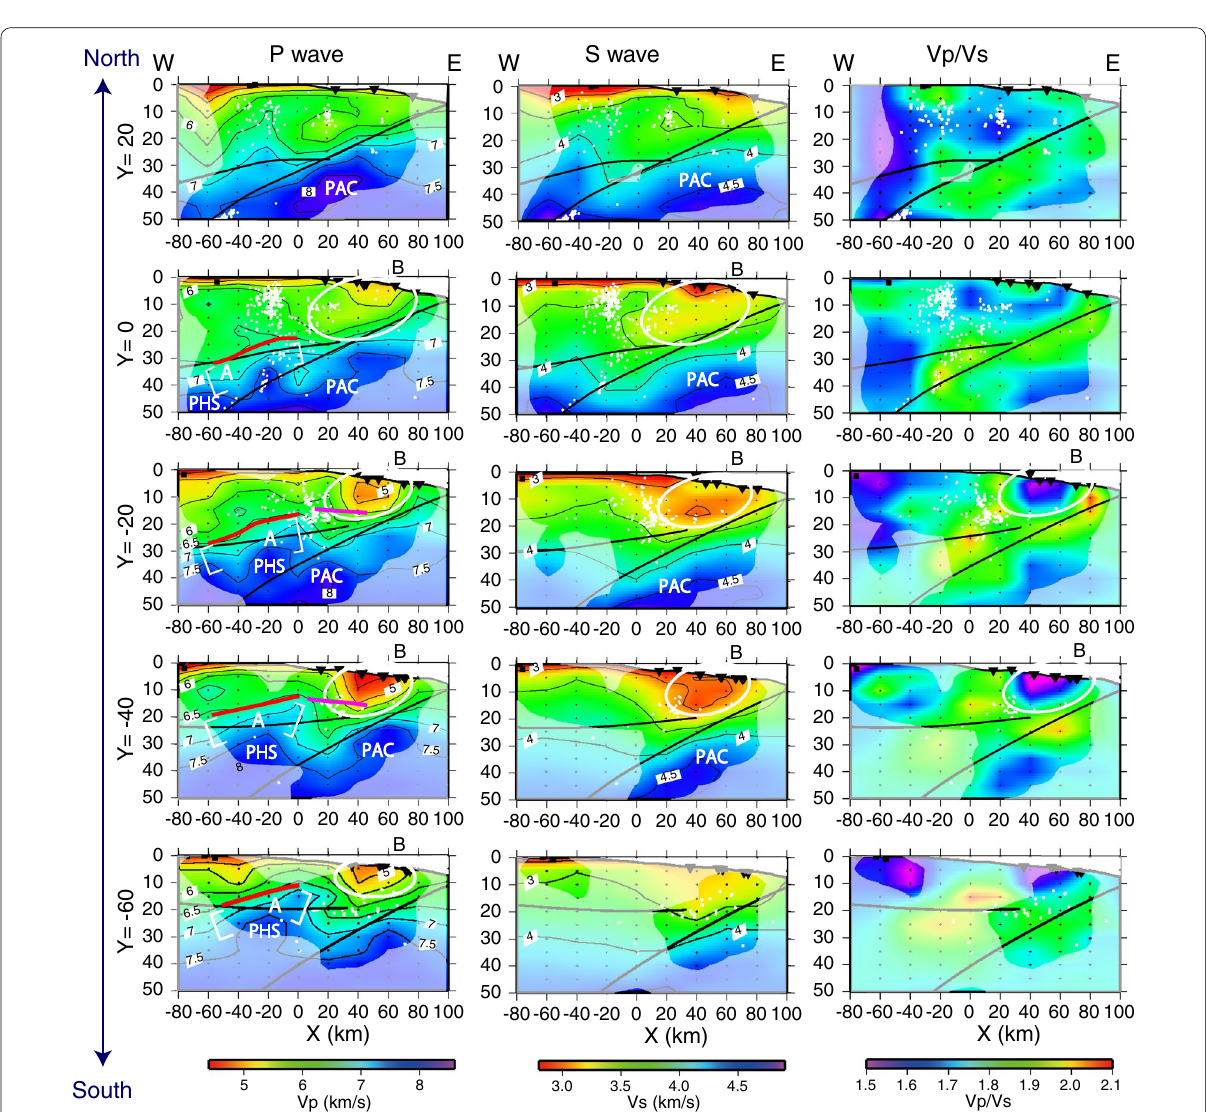
Fig. 4 Vertical profiles of velocity structure along the X axis shown in Fig. 2c. The contour interval of the velocity is 0.5 km/s. Black triangles and squares , and white circles indicate the locations of stations and earthquakes within 10 km from each section, respectively. Black bold lines indicate the location of the upper boundaries of the PAC (Nakajima et al. 2009) and PHS (Uchida et al. 2010). Red and magenta lines show the upper boundary of the PHS based on the present tomographic image and result of Ito et al. (2017), respectively. The crustal part of the PHS is indicated by areas labeled A. The other symbols are same as those defined in Fig.